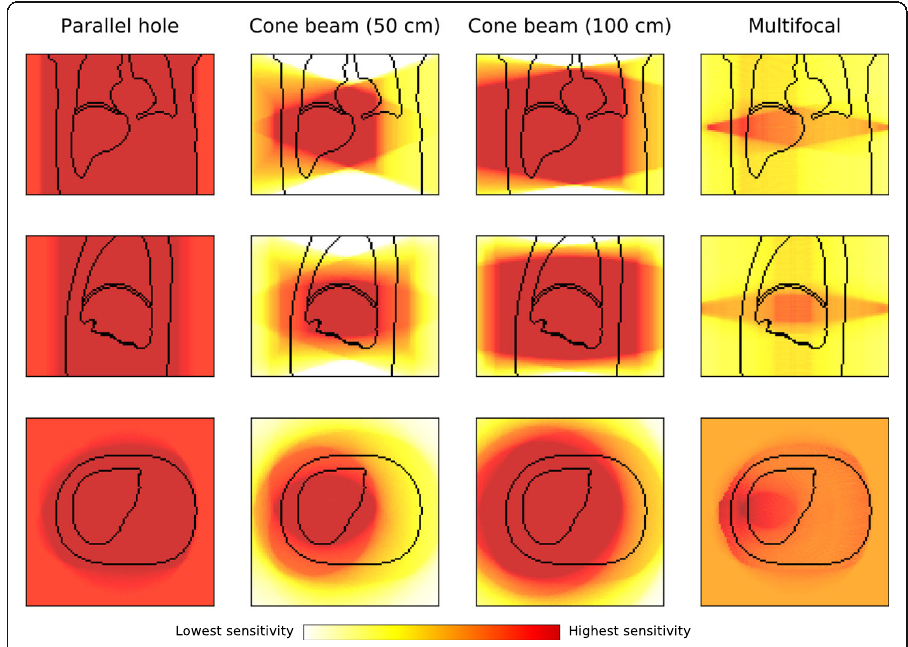
Fig. 2 From top to bottom are the coronal, sagittal, and transverse planes of the XCAT phantom (drawn are the body, liver, and lung contours) for the simulated collimators. The color gives an indication of the geometric sensitivity of each collimator. The detector surface follows a closed (non-circular) contour of